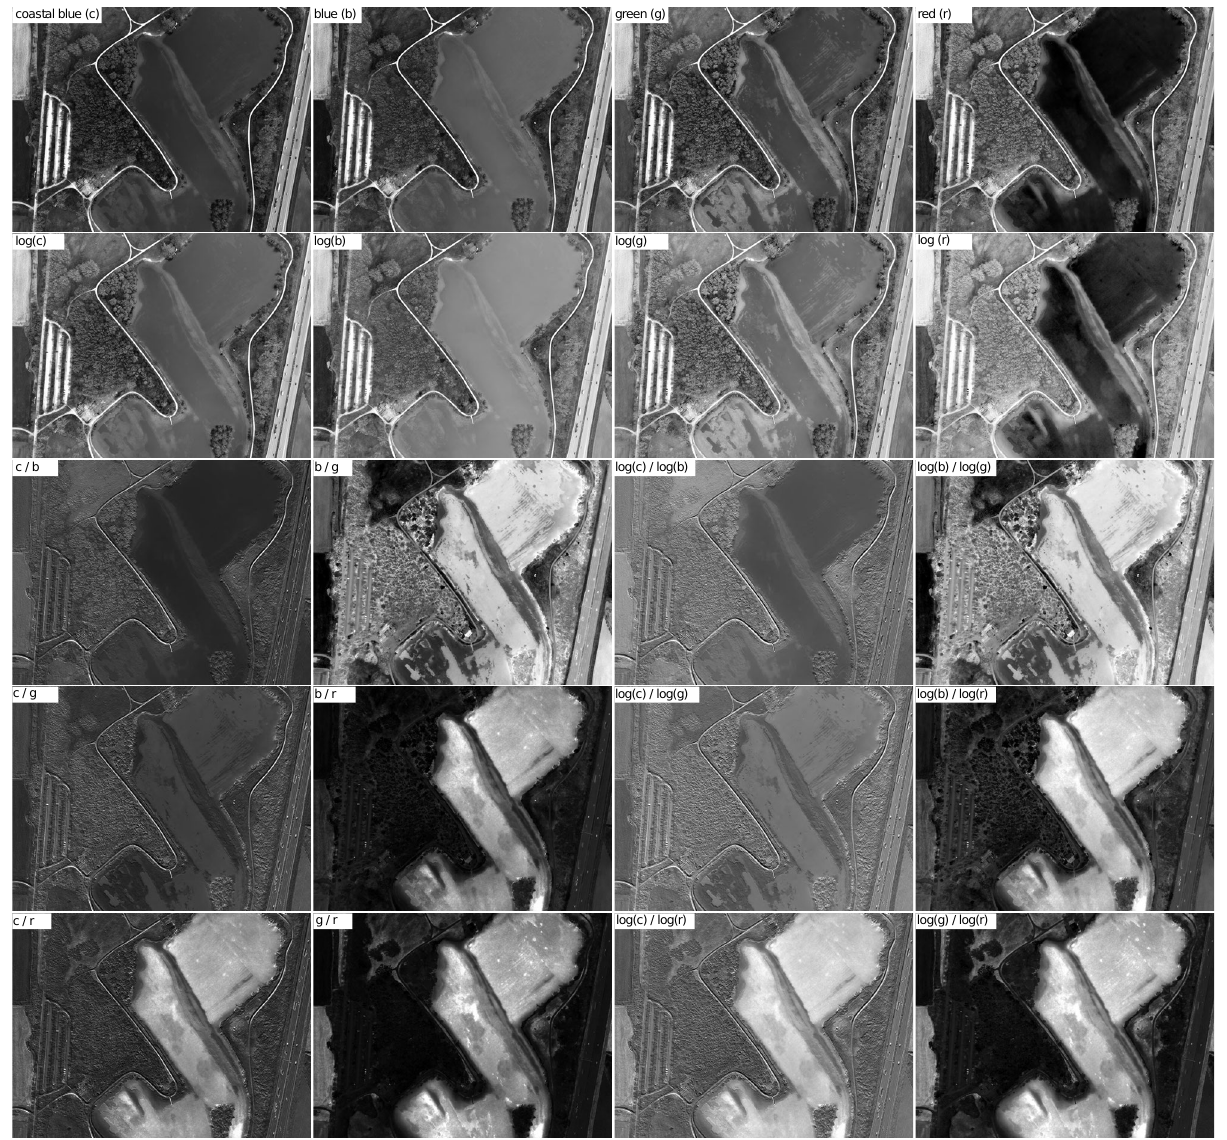
Figure 12. Image features derived from the four color channels; top row: coastal blue, blue, green and red band; second row: (natural) logarithms of color bands; lower left block: simple ratios of color bands; lower right block: ratios of logarithms of color bands showing a higher peak in the 0-20cm precision range compared to the Coastal Blue results. Also the key statistics underline the better performance of RGB (e.g. median: RGB=0.25 vs Coastal